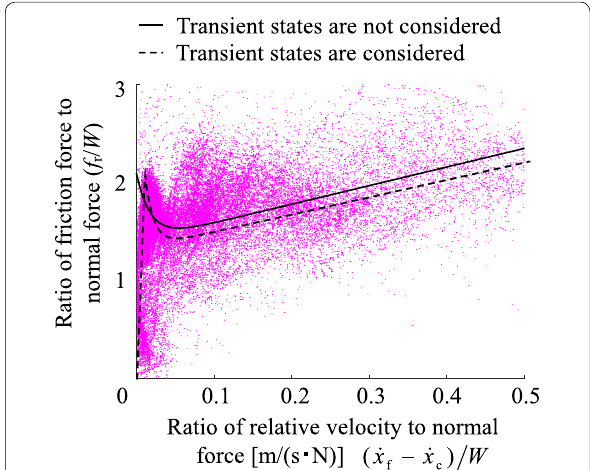
Fig. 6 Friction characteristic between contactor and finger. The solid line is the characteristic of maximum static friction and kinetic friction. The dotted line is the characteristic considering the transient states of the static